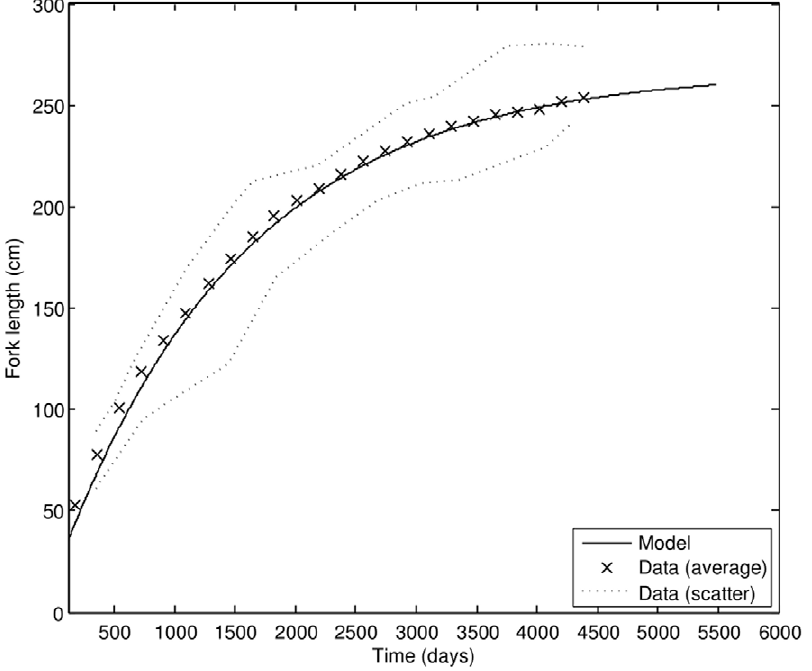
Figure 5. Growth of PBT in the adult stage; comparison of model results to observations (data source: [ 46 ] ).